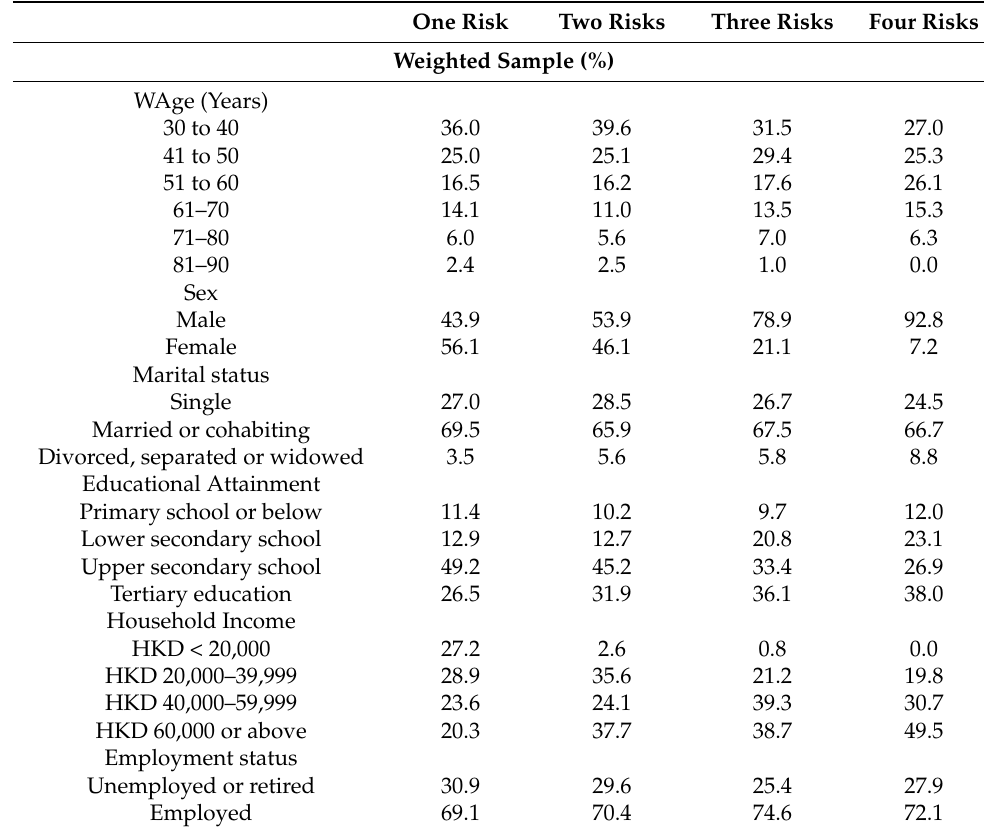
Table 3. Demographic characteristics of the participants with different numbers of health-risk behaviors ( N = 4605) a